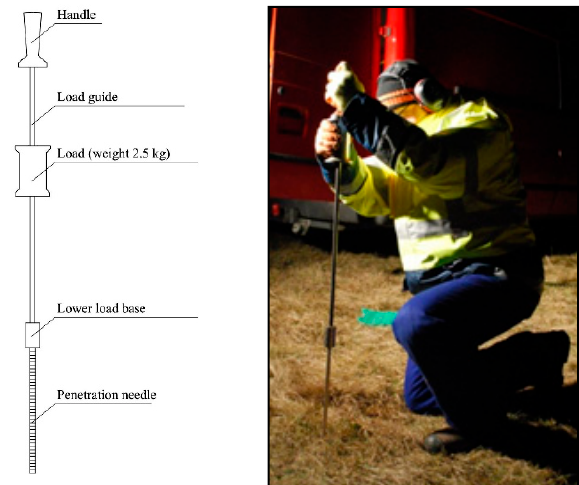
Figure 3. Diagram of the SD turf probe and the view of the measurements [41].